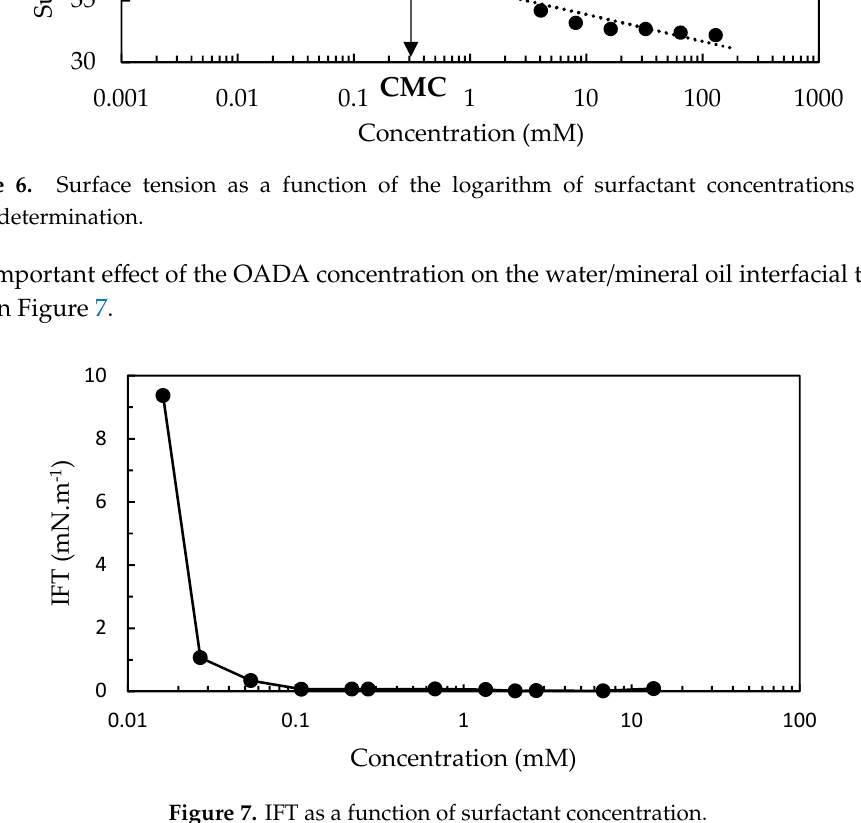
Figure 7. IFT as a function of surfactant concentration.